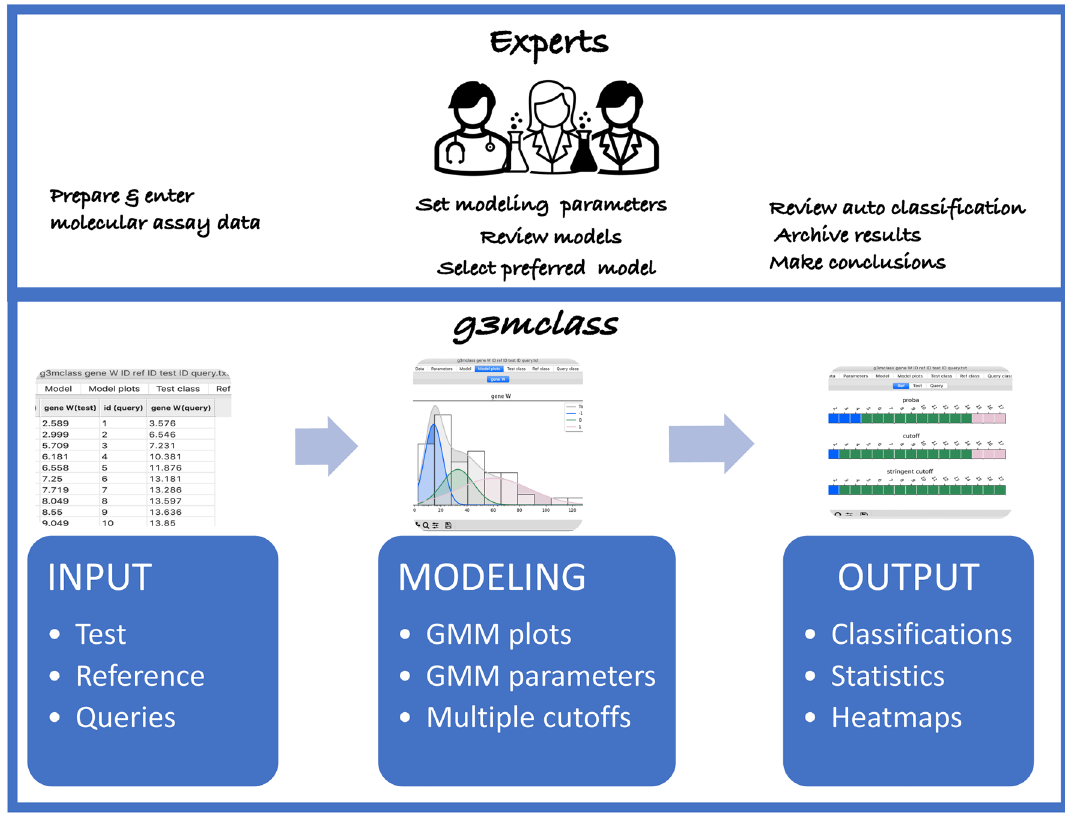
Figure 1. Graphical abstract of the g3mclass